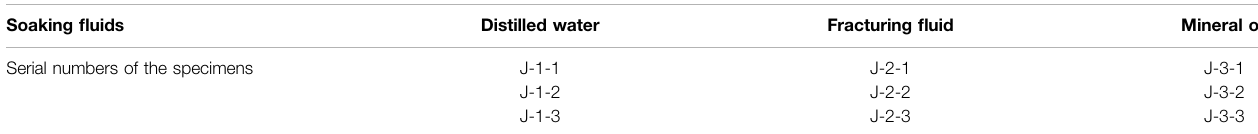
TABLE 2 | Allocation of specimens according to three types of soaking fl